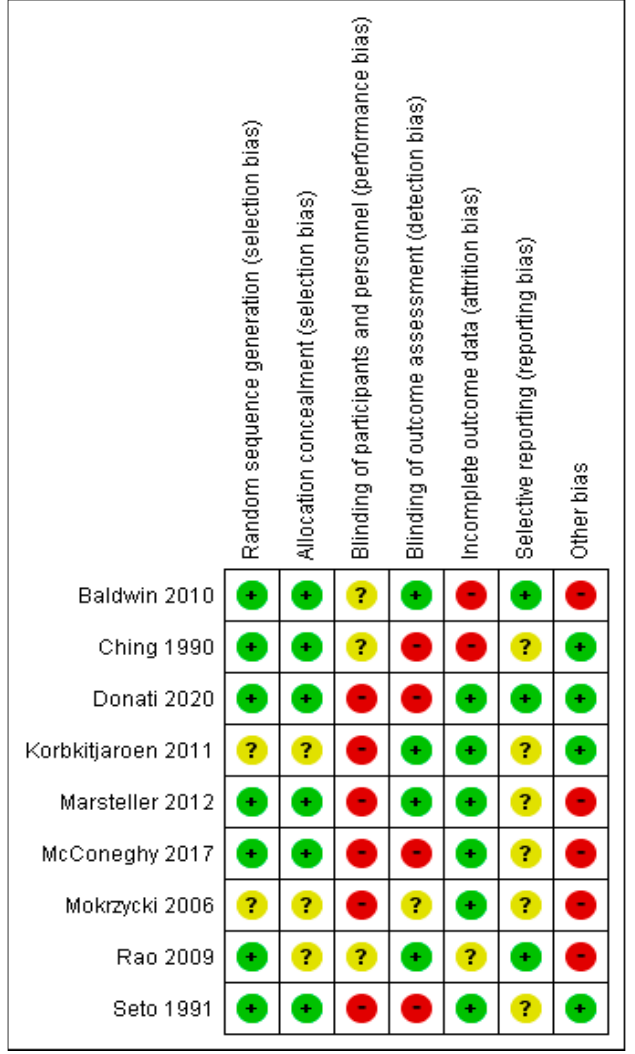
Figure 3. Risk of bias summary: review authors’ judgements about each risk of bias item for each included study [25–33].